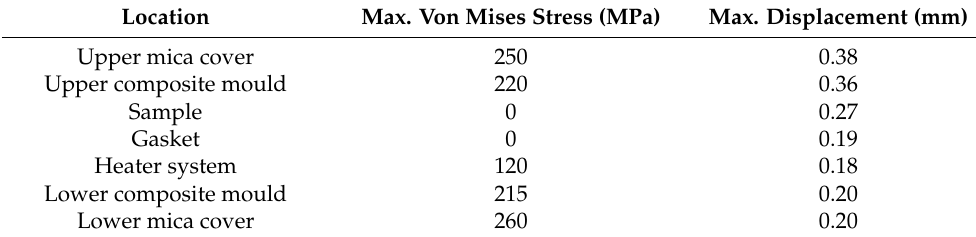
Table 5. Stresses and displacements at different